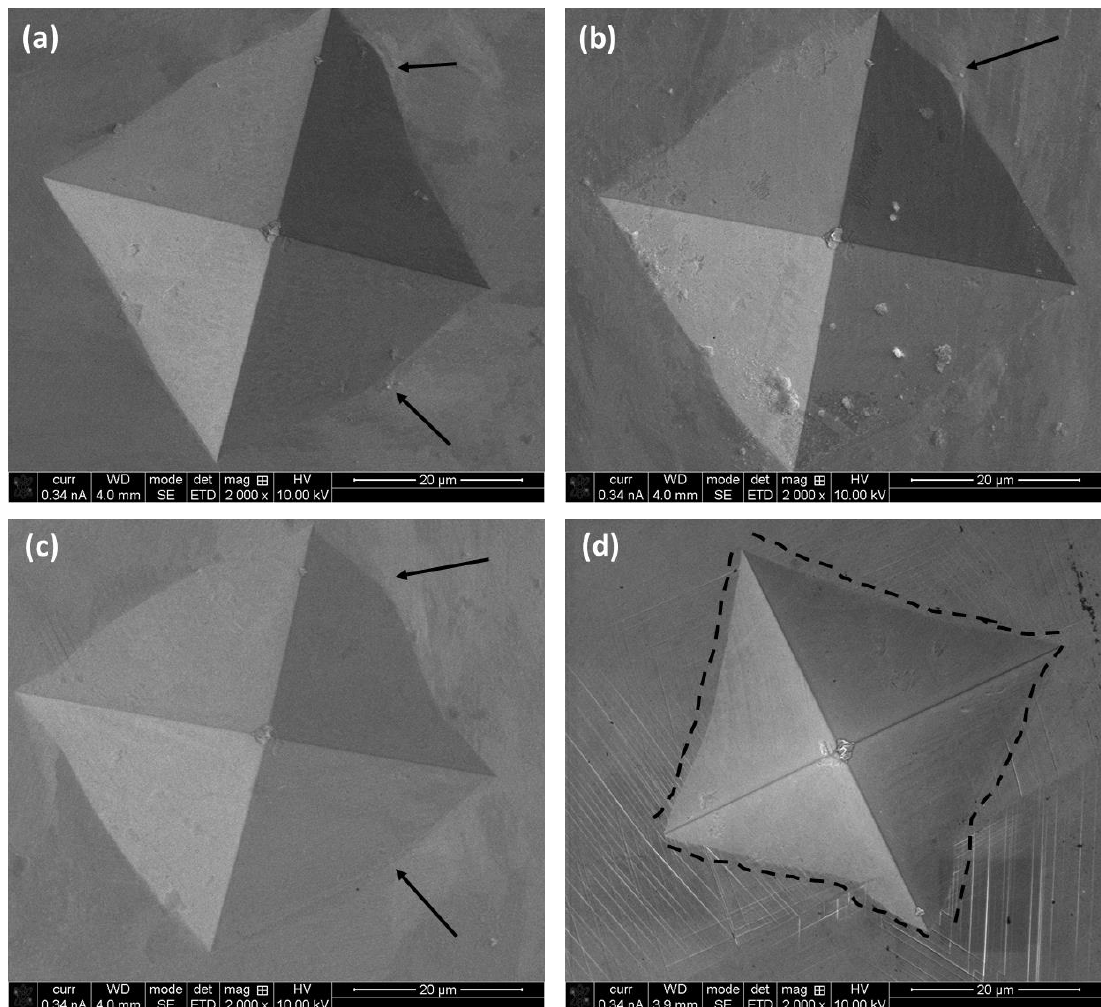
Figure 8. SEM images on residual imprints after Vickers’s indentation on L-PBF Inconel 718 alloy: ( d ) cast alloy. The black arrows indicate the ‘pile-up’ and the dotted line indicate the profile of the indentation mark.